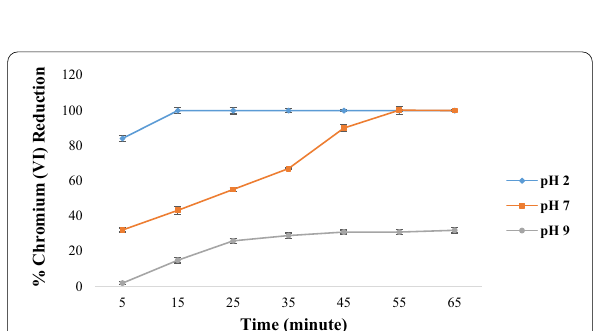
Fig. 5 Effect of reaction time on hexavalent chromium reduction by Tamarindus indica methanol leaves extract. (Extract concentration 1 mg/ml, chromium concentration = temperature 27 °C, pH 2.0, 7.0 and 9.0) = =